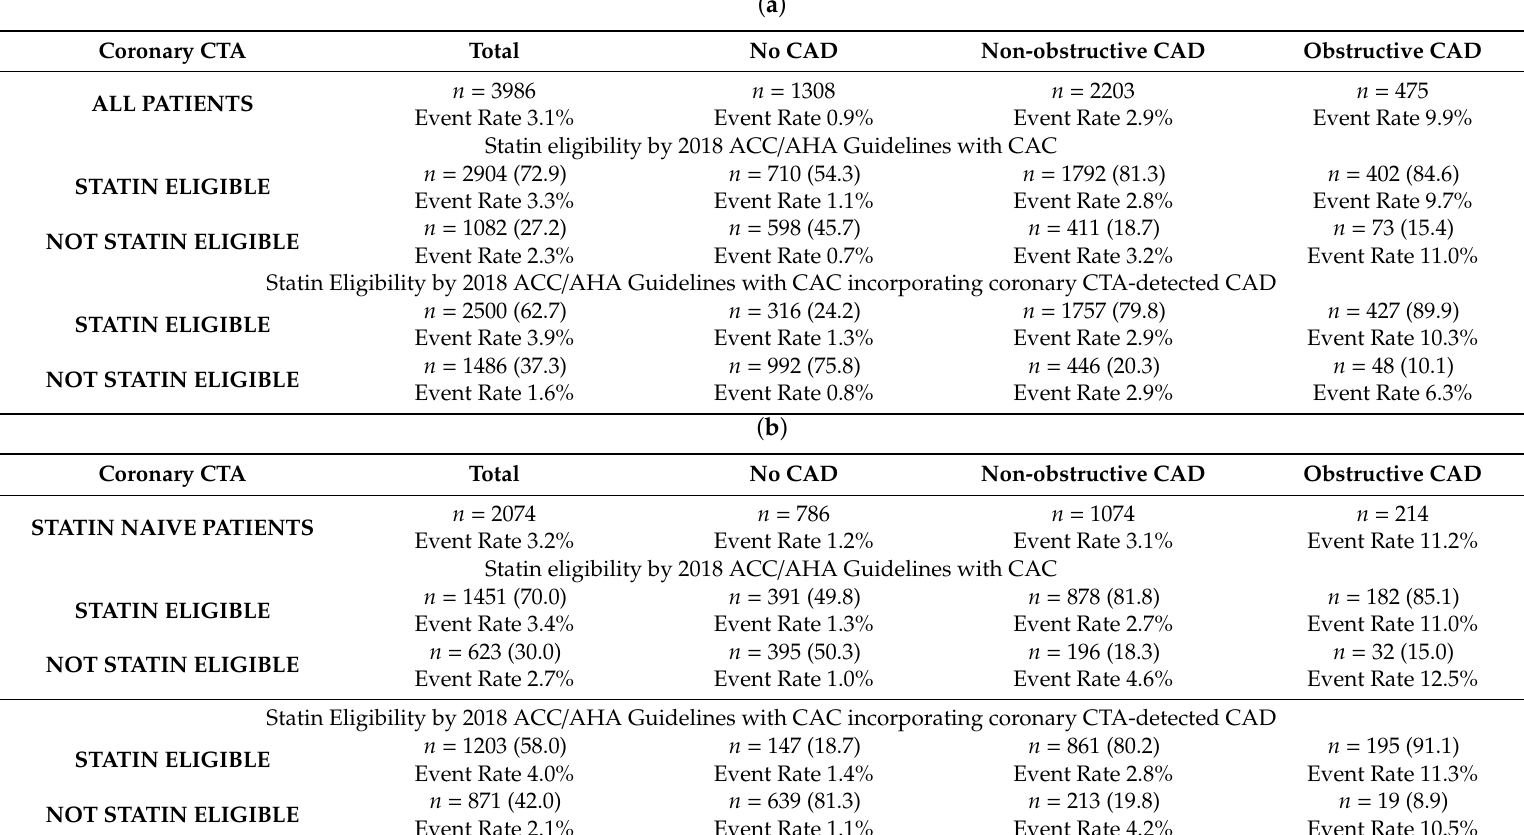
Table 2. Primary Event Rates Stratified by Statin Eligibility Status and Extent of CAD in: ( a ) all patients; and ( b ) statin naïve